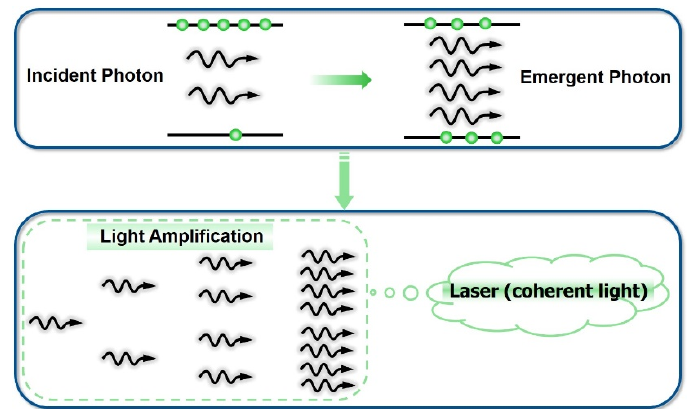
Figure 5. Energy level diagram of three-level laser materials and four-level laser materials.